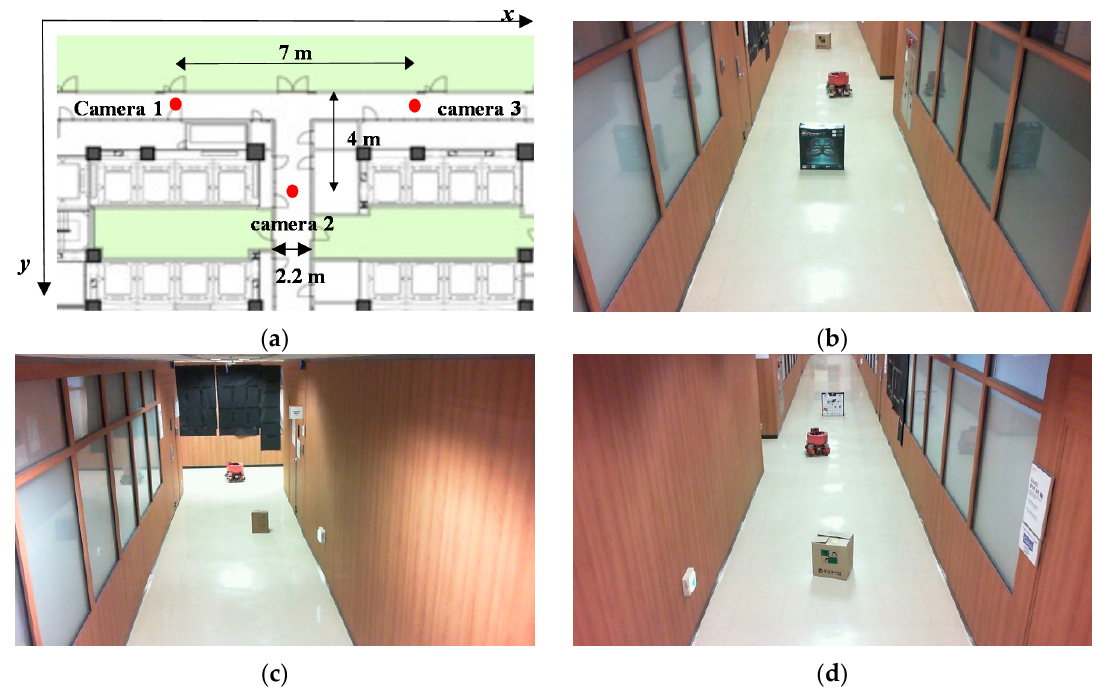
Figure 20. ( a ) Map of our experimental environment; ( b ) Image of camera 1; ( c ) Image of camera 2; ( d ) Image of camera 3.